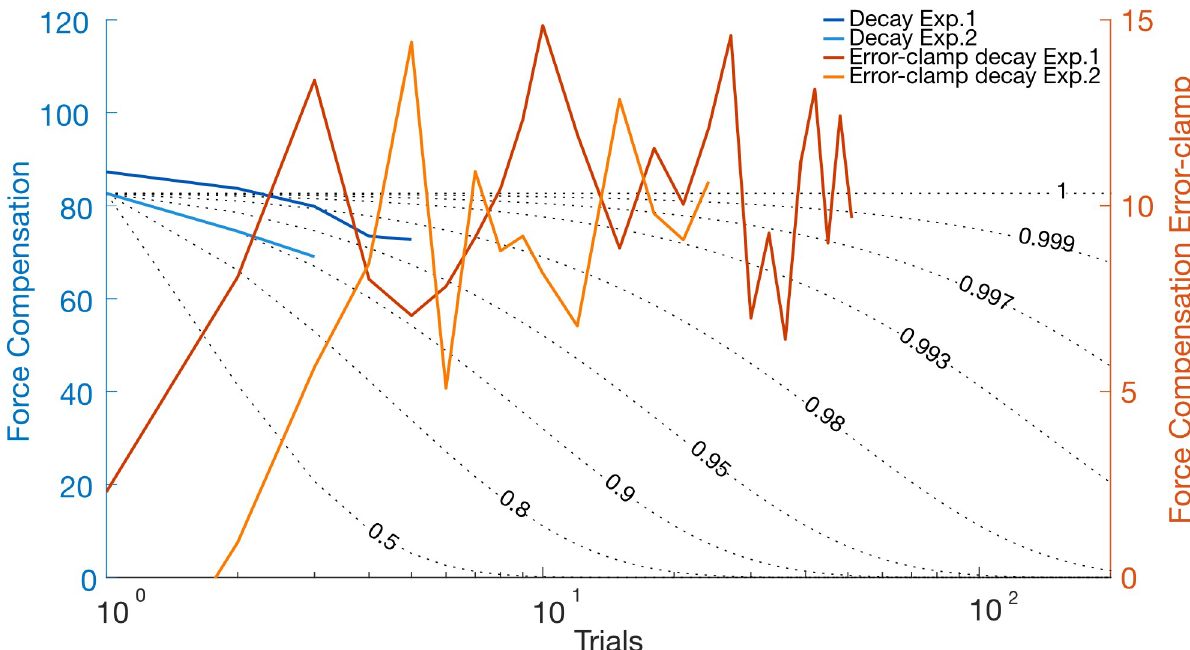
Fig 11. Decay of force compensation (mean across participants) for the decay blocks in the adaptation phase (blue, left y-axis) and in the error- clamp phase (orange, right y-axis) for experiment 1 (dark colors) and experiment 2 (light colors). Each data point in the error-clamp phase represents the mean of three trials. The scale for both y-axes was adjusted such that they can be compared to the simulated decay curves (black dotted lines). Nine retention curves were simulated with specific retention rates (0.5, 0.8, 0.9, 0.95, 0.98, 0.993, 0.997, 0.999 and 1), for comparison of retention rates and experimental data. Across all four experimental results, it is clear that a model must have a retention rate of greater than 0.993 for at least one of the processes in order to replicate these effects.